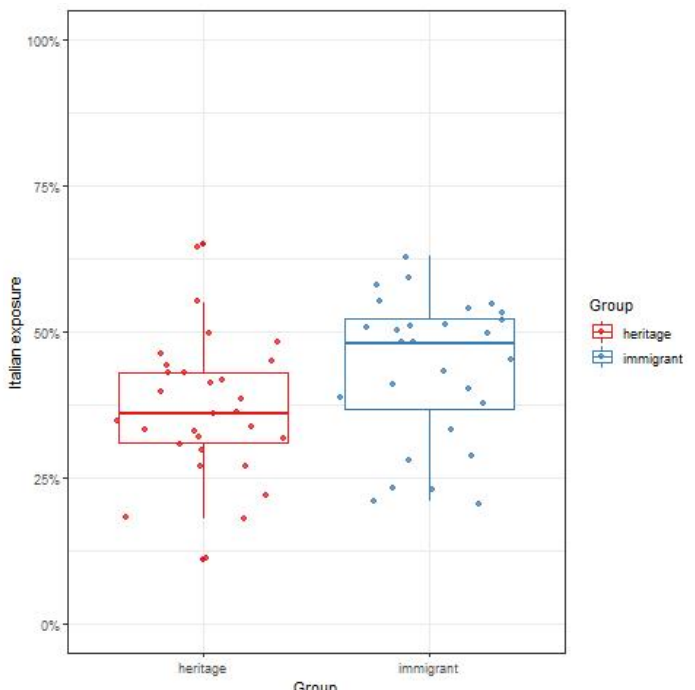
Figure 1. Correlation between group and exposure to Italian. The box draws the first, second and third quartile; whiskers extend to the maximum and minimum value excluding outliers.